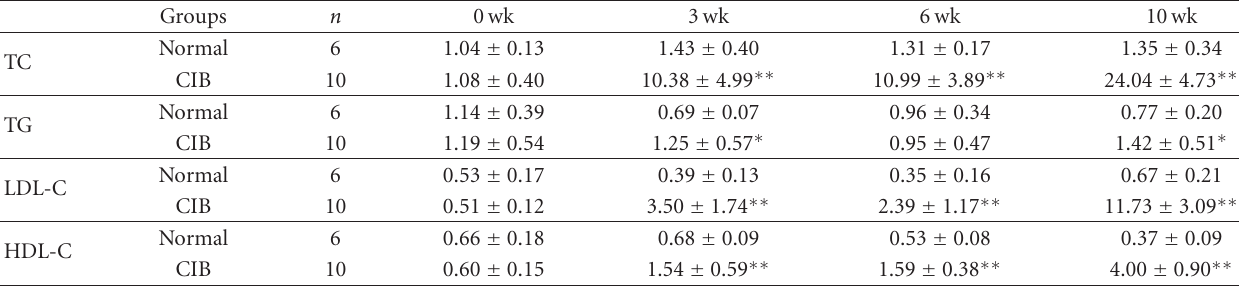
Table 2: Lipid profile of serum in the two groups